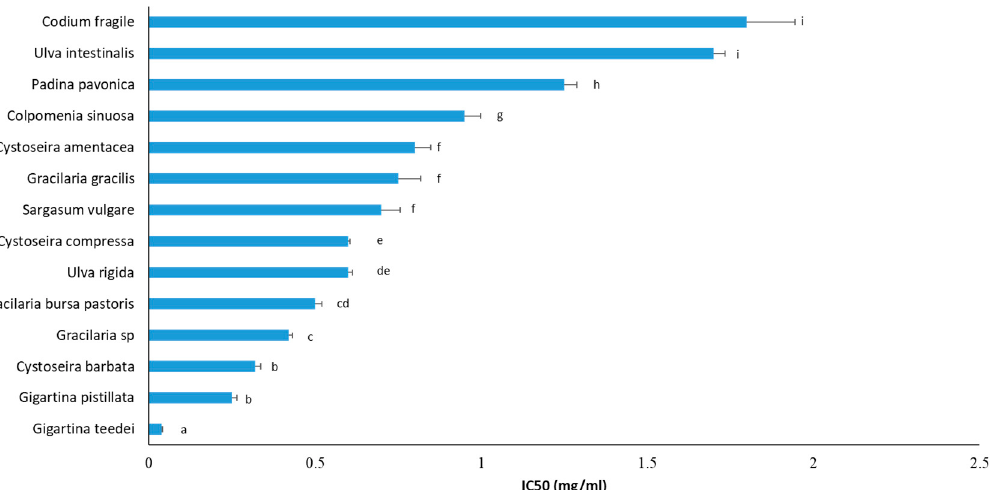
Figure 4. Protection from ROS-induced DNA damage of macroalgae extracts. The IC 50 values are presented as the mean ± SD from at least three independent experiments. All IC 50 values are statistically significant ( p < 0.05) compared to controls. Values having different letters are statistically different between them ( p < 0.05).